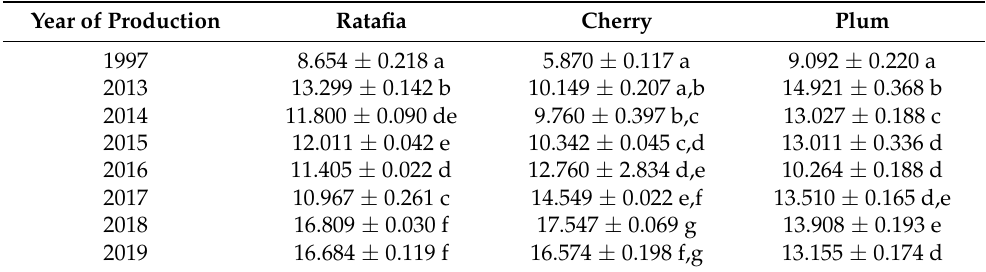
Table 3. The antioxidant activity of nalewkas was measured by the FRAP method (mean ± SD, n = 3). Different letters indicate significant differences between the individual years. The result was expressed in mg FeSO 4 · g − 1 of nalewka.